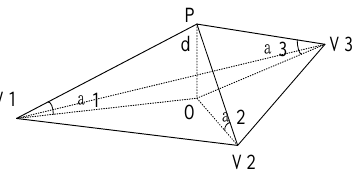
Figure 3. Progressive triangular filter geometry diagram